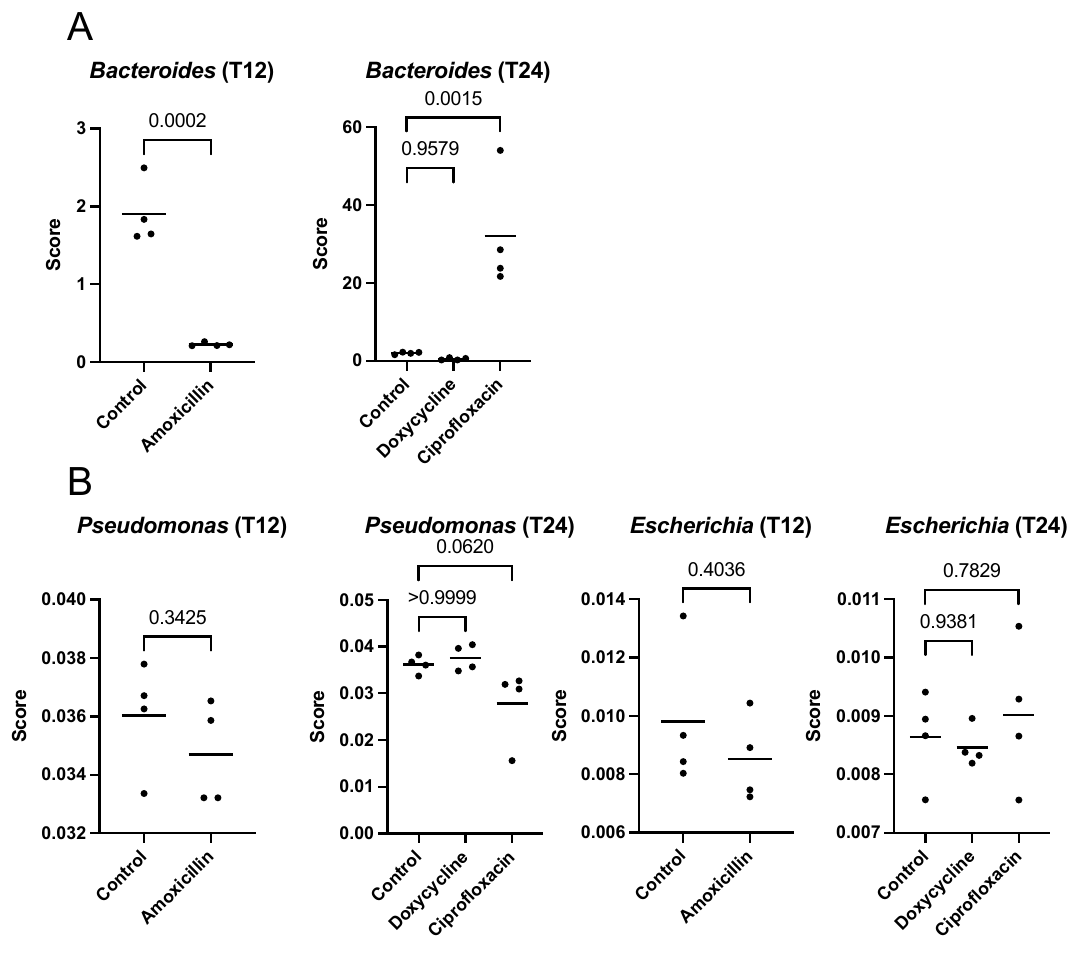
Figure 4. Fluctuation of populations of Bacteroides ( A ), and Pseudomonas and Escherichia ( B ) for T12 and T24. p values are shown for all comparisons versus controls.